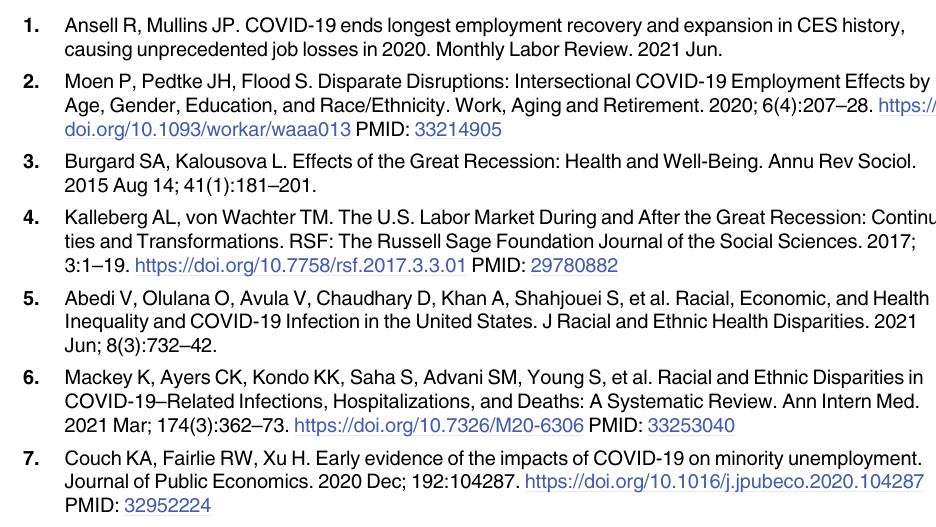
S3 Table. Fixed-effects models predicting men’s full-time employment by immigrant sta- tus, race/ethnicity and partnership in marriage or cohabitation in 2020 relative to 2019.